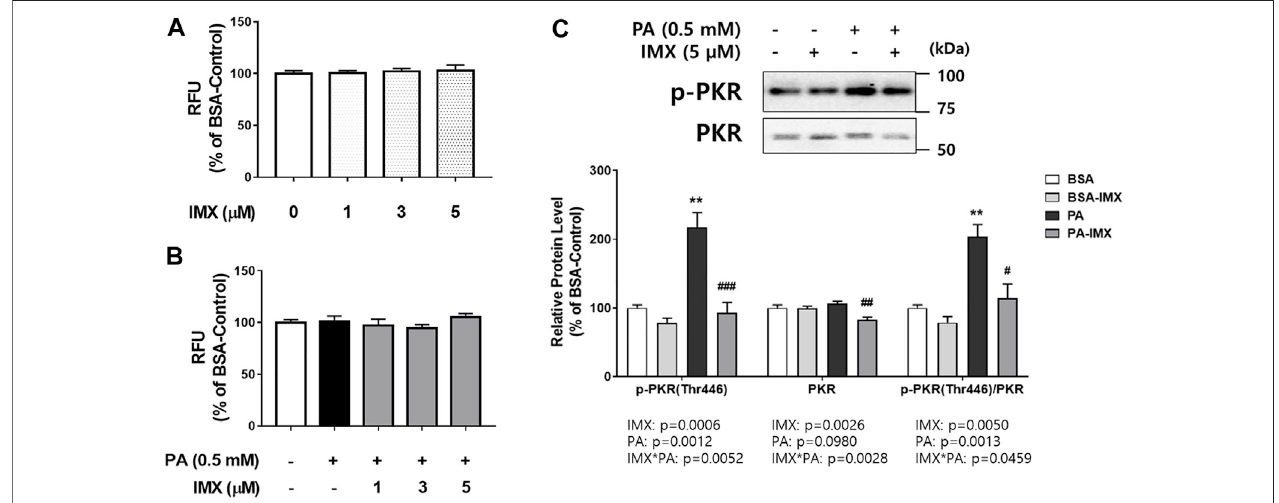
FIGURE1| EffectofpalmitateandimoxinonPKRphosphorylationinC2C12myotubes.Cellsweretreatedwith5 μ Mimoxin(IMX)withorwithoutmediacontaining 0.5 mM BSA-conjugated palmitate (PA) for 24 h. Cell viability was assessed (A, B) . Protein levels of p-PKR (Thr446) and total PKR were measured by western blot (C) . Representative images are shown on the top panel and quanti fi cation is shown on the bottom. Data were analyzed by two-way ANOVA (IMX x PA) followed by Tukey ’ s post-hoctest.Valuesarepresentedasmean±SEM(N=3).** p < 0.01comparedwiththeBSA-controlgroup;# p < 0.05,## p < 0.01,### p < 0.001comparedwith the PA-only